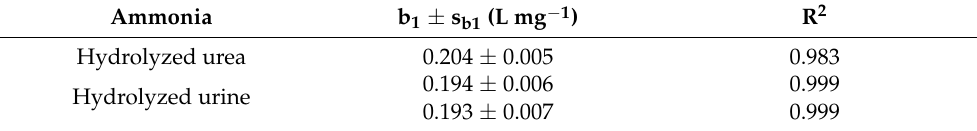
Table 6. Ammonia concentration found in hydrolyzed urine samples by the thymol-based sensor.